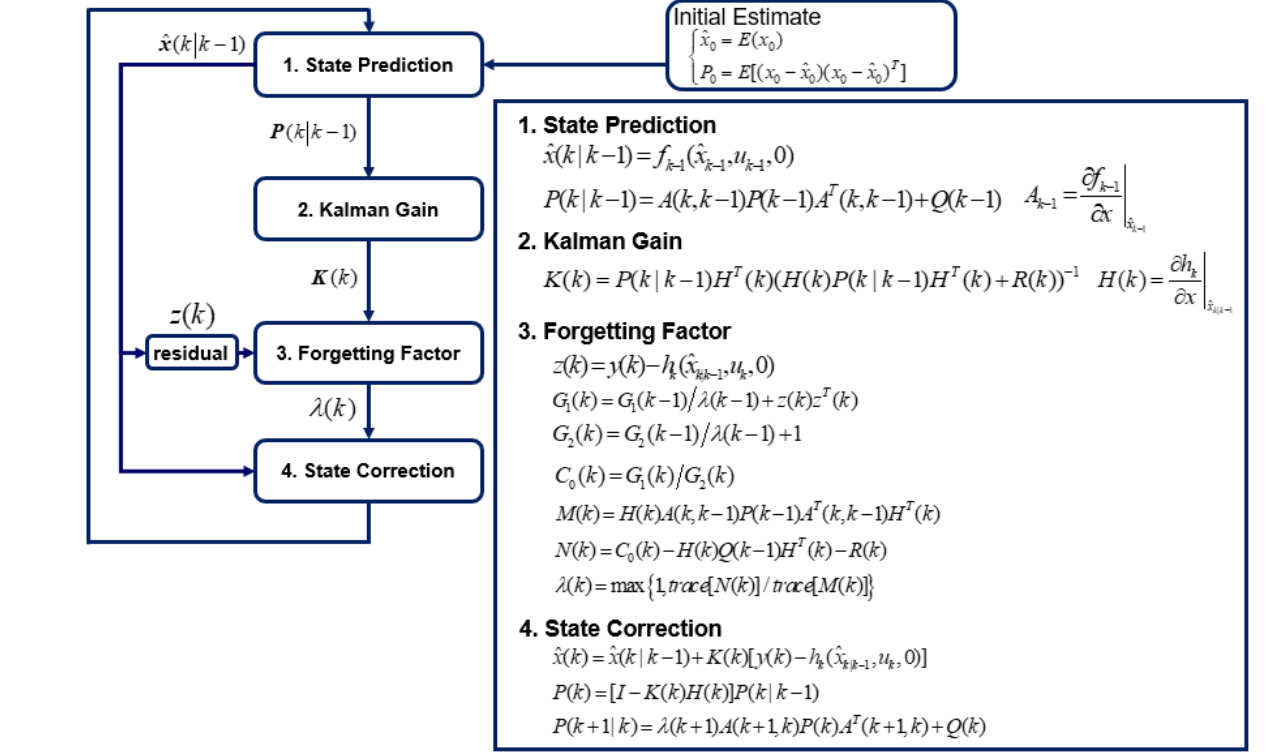
Figure 3. Overall flow chart of the AEKF algorithm for estimating the time-varying shaft torsional stiffness.